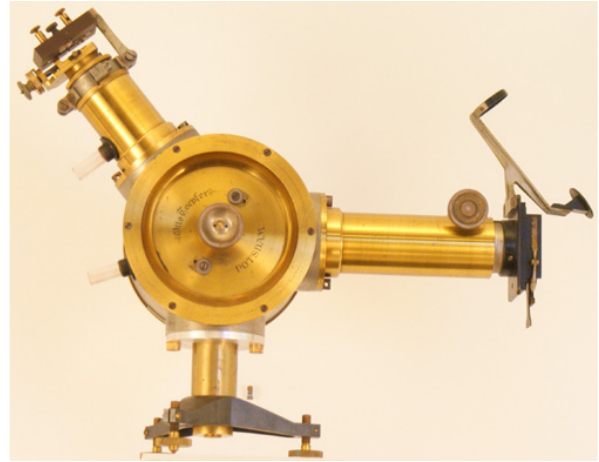
Figure 17. Toepfer spectrometer with mount for calibration light sources at the entrance (left) and sighting means mounted at the rear part (right) (Photo,